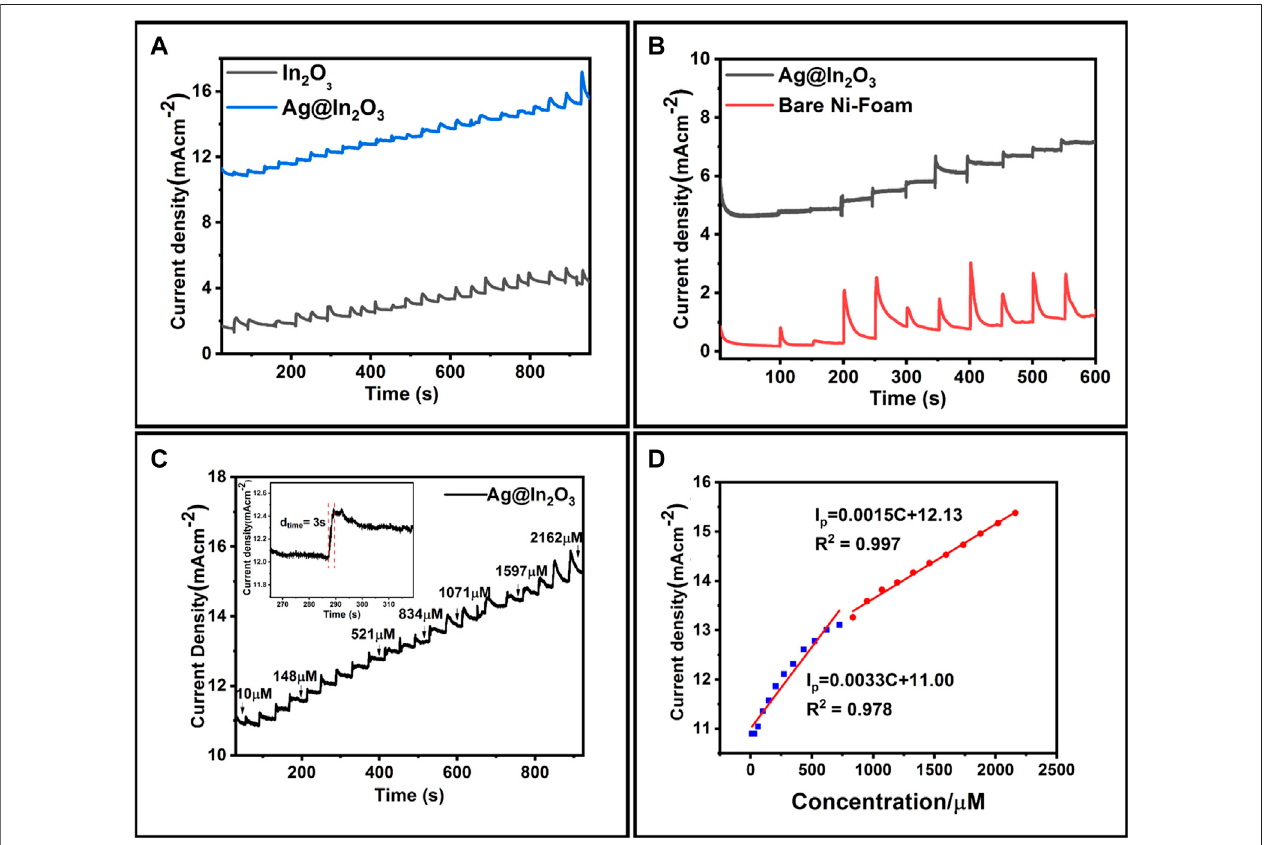
FIGURE 7 | (A) Amperograms of Bare NF and Ag@In 2 O 3 in NaOH (0.1 M) stirred solution with different glucose concentrations, (B) Amperograms of In 2 O 3 and Ag@In 2 O 3 , (C) AmperogramofAg@In 2 O 3 modi fi edNFat+0.7 Vobtainedfromthestepwiseadditionsofvariousglucoseconcentrations(30 µlafterevery40 sinterval)in the range of 10 – 2200 µM (inset: magni fi ed amperogram showing current response of 3 s), (D) Two linear ranges at +0.7 V of calibration curve between glucose concentration and current response.